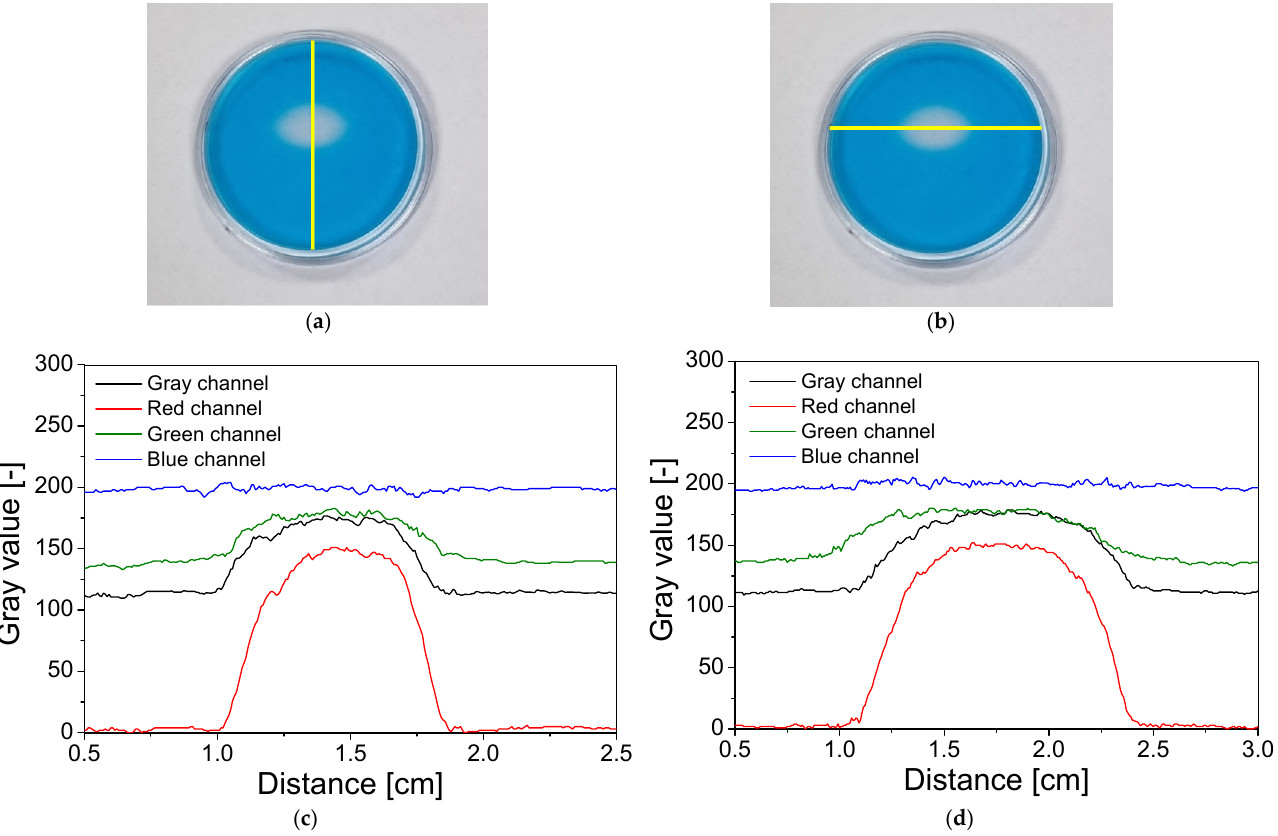
Figure 10. The photographs of partially irradiated TBO ‒ Pluronic F ‒ 127 sample ( a , b ) and the profiles across ( c ) and along ( d ) the sample for a raw image (grey channel) and all RGB channels (red, green and blue) ( c , d ). The yellow lines in the photographs ( a , b ) indicate the position of profiles ( c , d ).